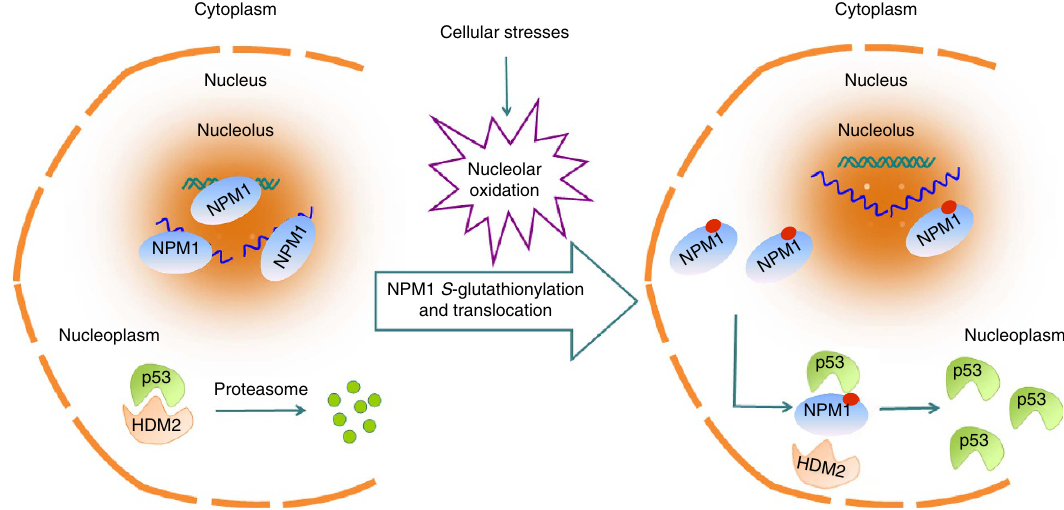
Figure 9 | NPM1 sensing for nucleolar stress. Nucleolar oxidation is a general response to various cellular stresses. During nucleolar oxidation, NPM1 undergoes S -glutathionylation on Cys 275 , which triggers the dissociation of NPM1 from nucleolar nucleic acids. The nucleoplasmic NPM1 is indispensible for p53 activation induced by nucleolar